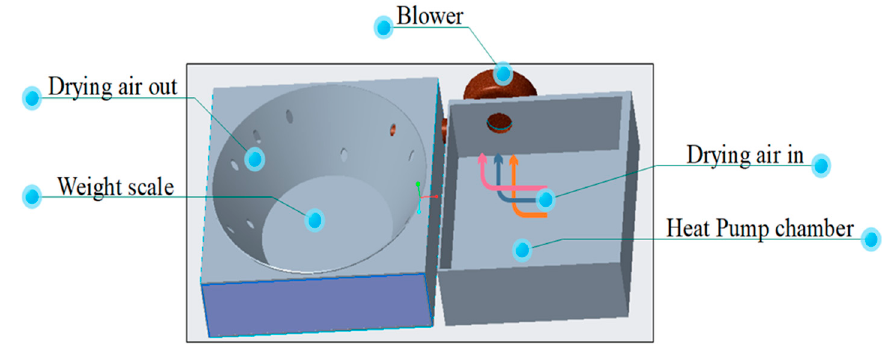
Figure 3. Heat pump drying chamber.